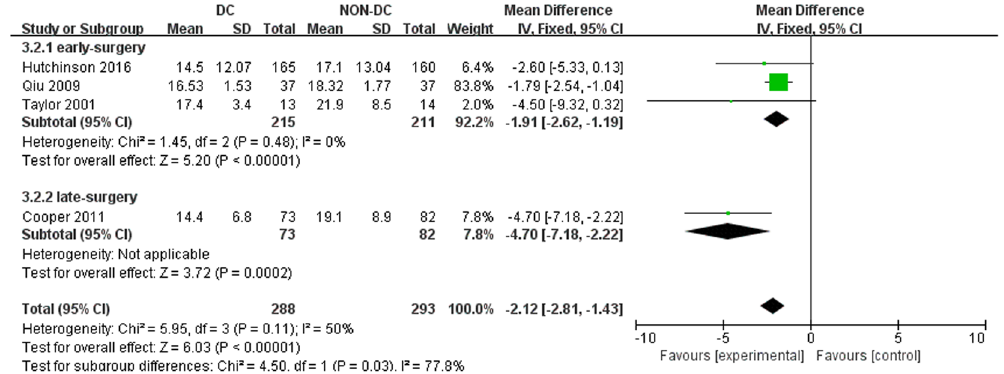
Figure 4. Forest plots for the effect of DC versus NON-DC on ICP reduction. DC, Decompressive Craniectomy; ICP, Intracranial Pressure.